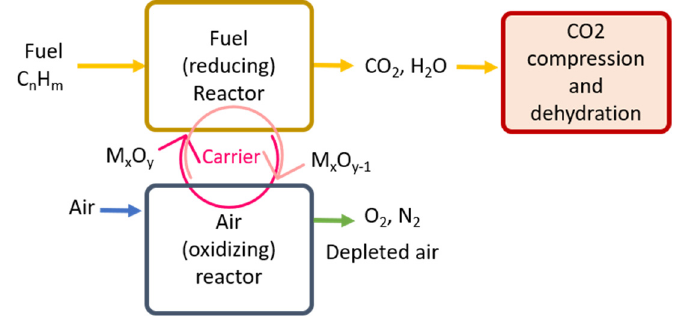
Figure 12. Scheme and streams of the CLC process. Adapted from: [131].